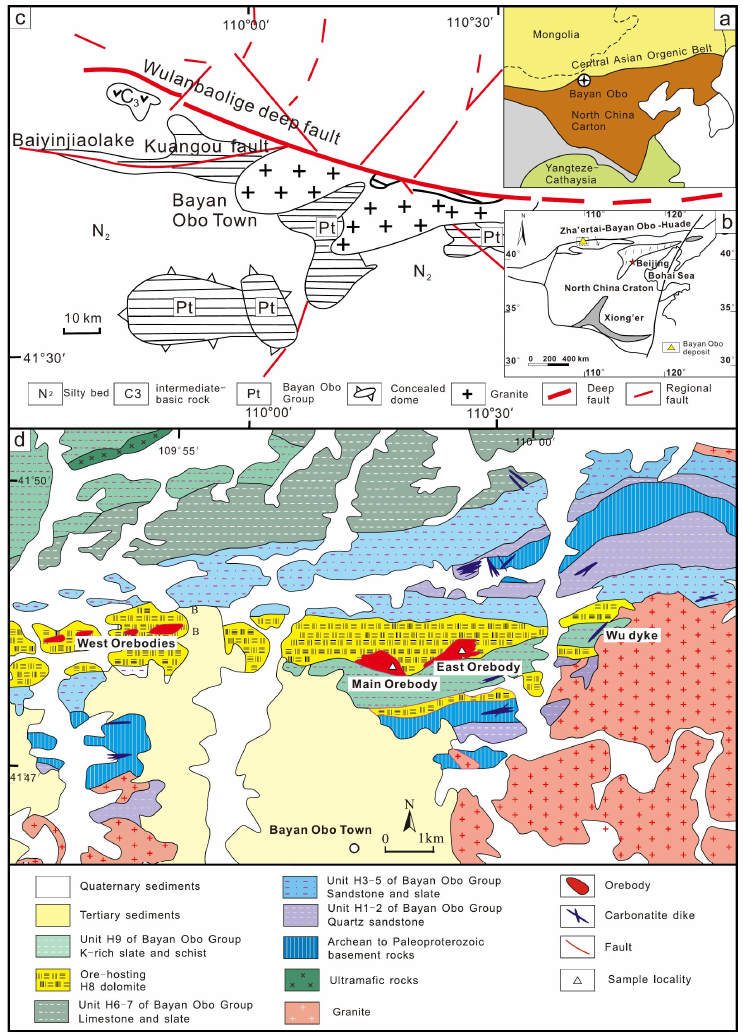
Figure 1. Location and stratigraphy of the Bayan Obo deposit. ( a ) The tectonic location in the North China Craton (modified from [25] ); ( b ) geological map of the North China Craton (modified from [26] ); ( c ) regional structural geological map of the Bayan Obo region (modified from [2] ); ( d ) geological map of the Bayan Obo deposit and surrounding area (modified from [8] ).